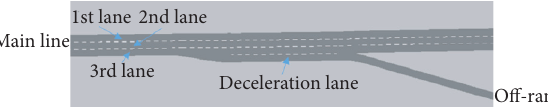
Figure 3: Screen capture of the VISSIM simulation model in the off-ramp area.